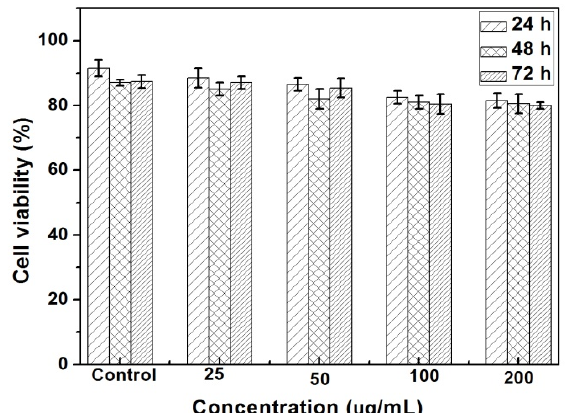
Figure 6. Cytotoxicity evaluations test of A549 cells with different concentrations of CDs 40min after 24, 48 and 72 h incubation.